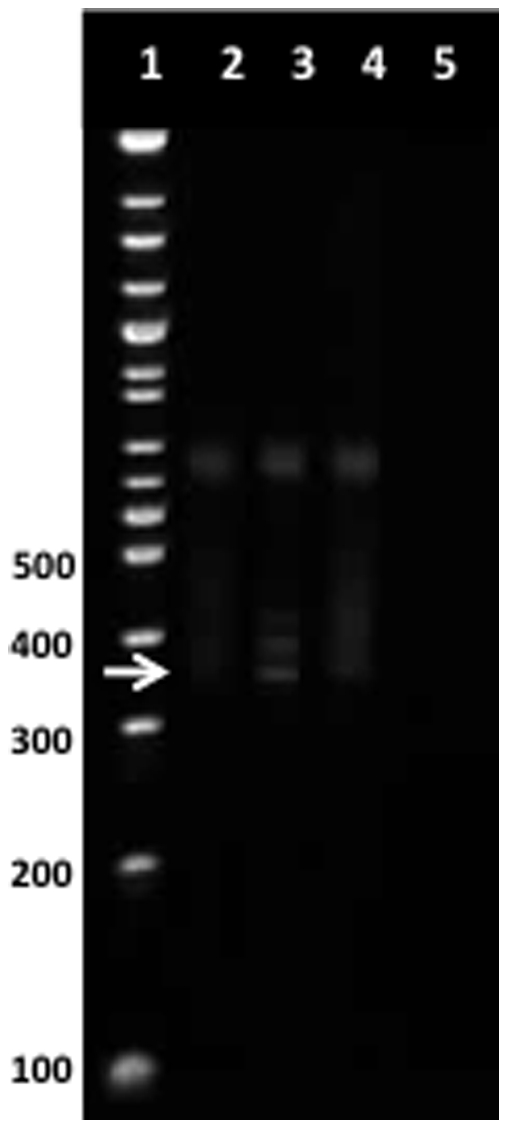
Clonal Vγ9 rearrangement in γδ+ T-cells.Example of Vδ2Jγ9 clonality detection in patient number 4 (Table 1). PCR with Vg2-Jg1.2 primers was carried out on FACS sorted cell fractions and the clonal products were identified by heteroduplex analysis. Lane 1, DNA ladder; lane 2 αβ+ T-cell fraction; lane 3 γδ+ T-cell fraction; lane 4 pool of healthy controls showing polyclonal smear; lane 5, water control. Clonal PCR product in the γδ+ T-cell fraction is shown with a white arrow.